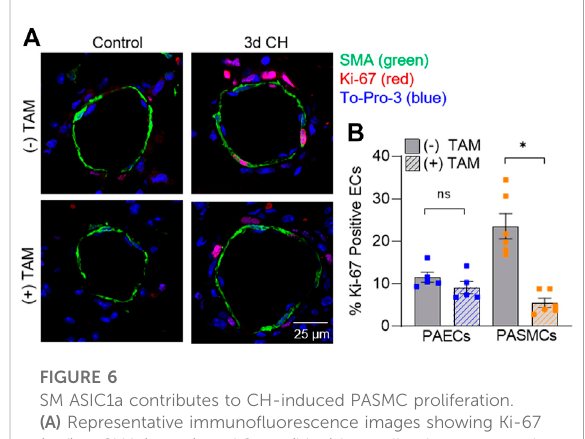
FIGURE 6 SM ASIC1a contributes to CH-induced PASMC proliferation. (A) Representative immuno fl uorescence images showing Ki-67 (red), α -SMA (green), and Sytox (blue) in small pulmonary arteries ( < 100 µm) from control and 3 days CH MHC CreER - Asic1a fl / fl mice following treatment with vehicle or tamoxifen (TAM). (B)